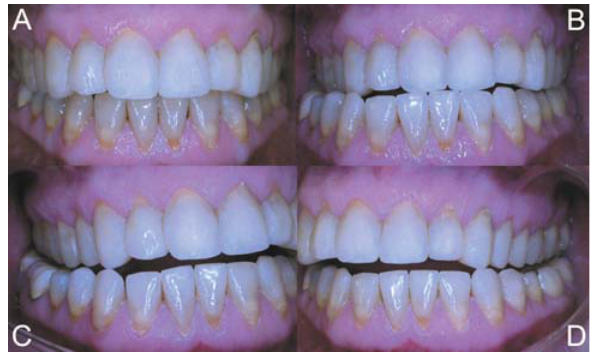
FIGURE 6- Functional aspects of restored teeth. A: view of restored teeth immediately after restoration; B: protrusion; C: right lateral guidance; D: left lateral guidance